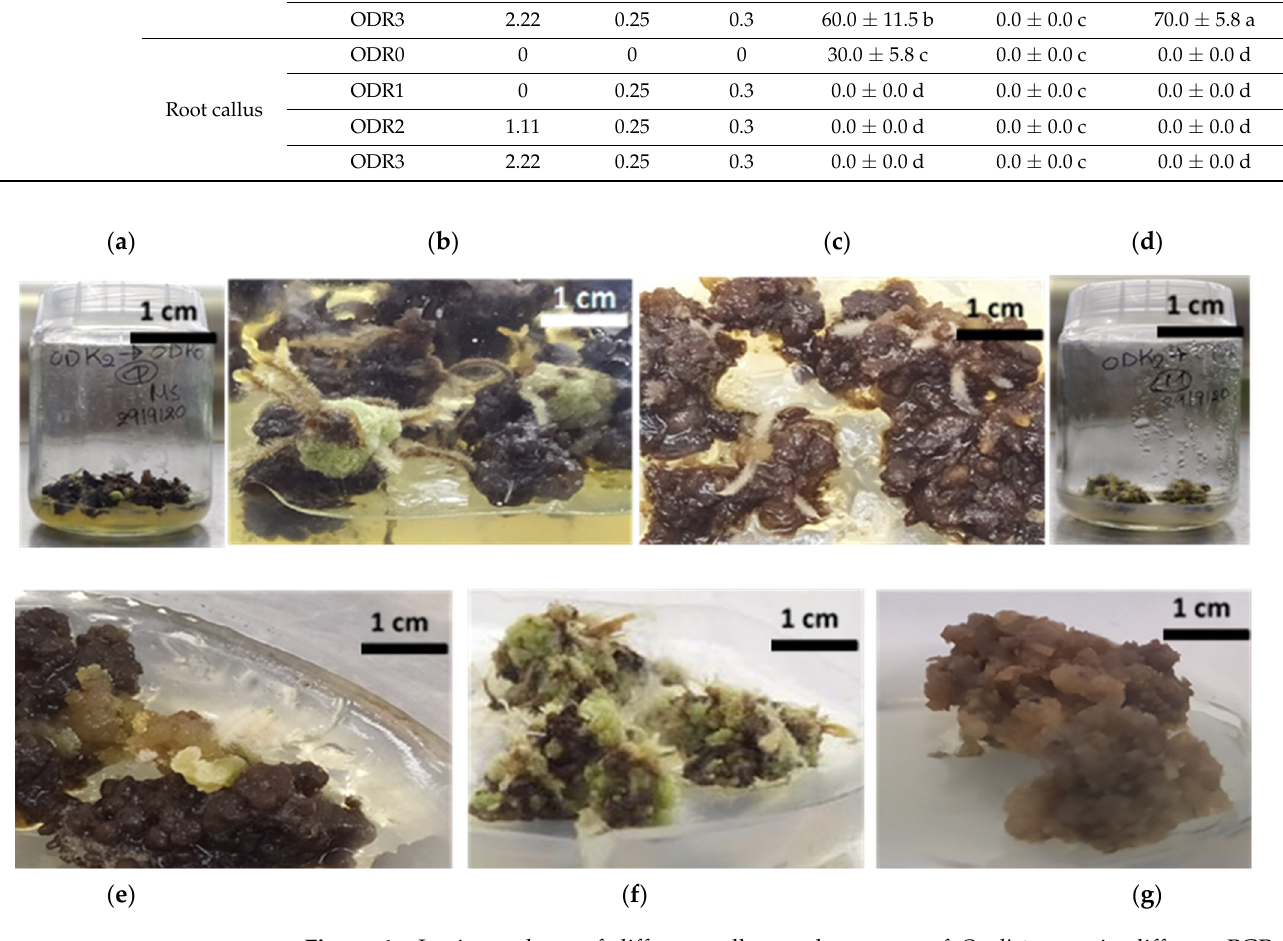
Figure 4. In vitro culture of different callus explant types of O. dictamnus in different PGRs-supplemented MS media: ( a – c ) New callus and root regeneration from leaf-callus when transferred from ODK2 to ODR0; ( d – f ) Differentiation of petiole callus into new callus and roots after transferred from ODK2 to ODR3; ( g ) Root callus turned brown after successive subcultures in ODR0. (Scale bar: 1 cm). 1 Table 2. Effect of explant type (leaf callus, petiole callus, root callus) of O. dictamnus L. and different